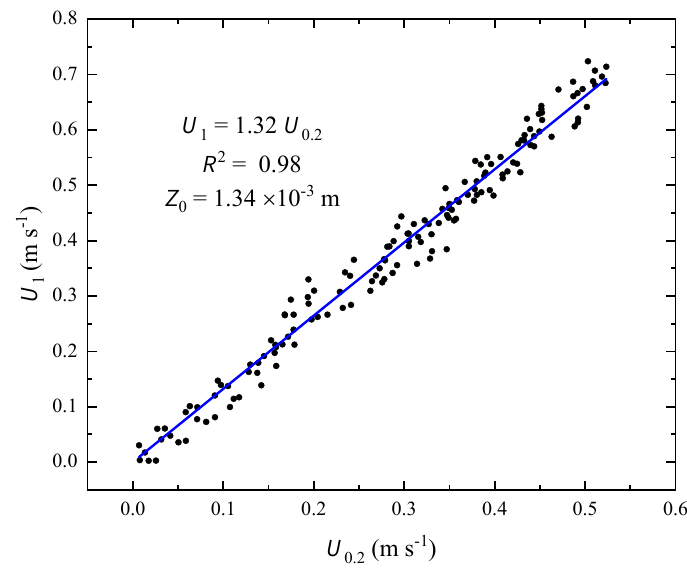
Figure 3. The linear regression between U 0.2 and U 1 (current speeds (magnitudes of the velocity) at 0.2 and 1 m asb, respectively). Z 0 (m) derived from the slope of the regression denotes the average during the observation period.